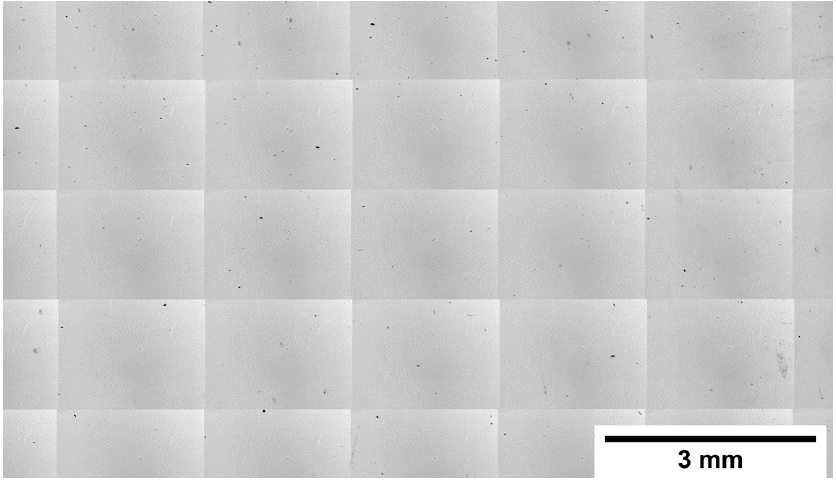
Figure 1. Representative optical micrograph of stitched 50× images from the cross-section of an as-built cubic sample from its polished state.